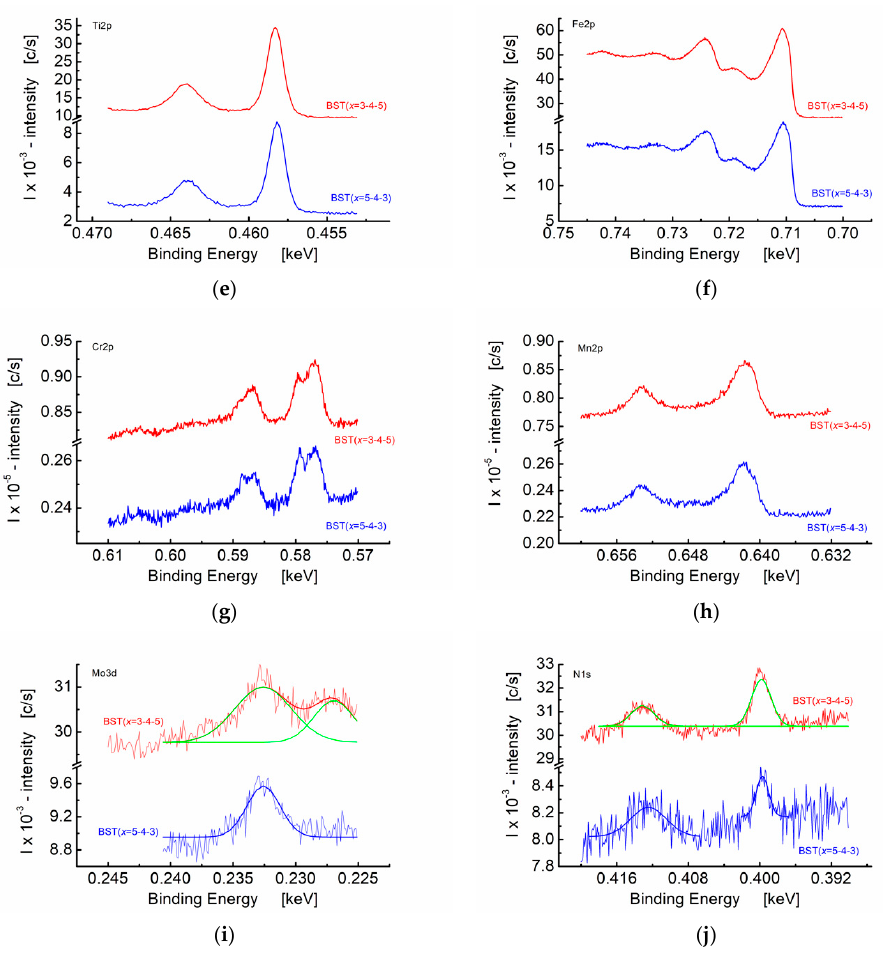
Figure 8. X-ray photoelectron high-resolution spectra for BST thin films differing in the sequence of deposition of the barium strontium titanate layers constituting the thin film. BST ( x = 5-4-3)—blue line, and BST ( x = 3-4-5)—red line. ( a ) C 1s, ( b ) O 1s, ( c ) Ba 3d, ( d ) Sr 3d, ( e ) Ti 2p, ( f ) Fe 2p, ( g ) Cr 2p, ( h ) Mn 2p, ( i ) Mo 3d, and ( j ) N 1s.